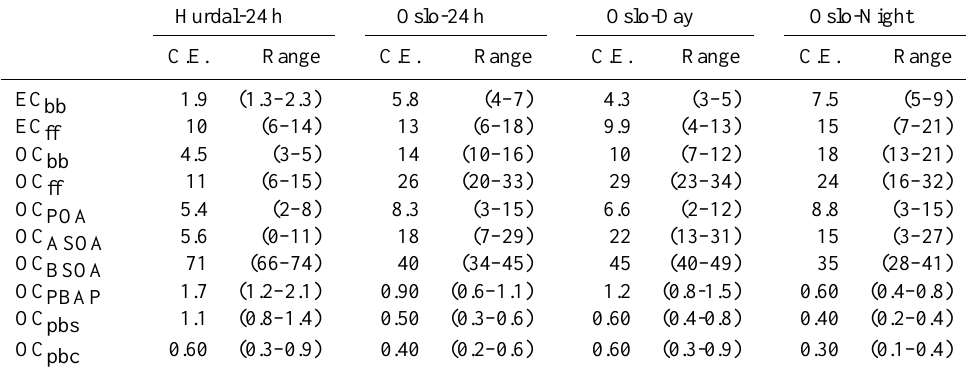
Table 8. Calculated percentage contributions to total carbon from LHS analysis, PM 1 , summer sampling (19 June–15 July 2006). C.E. is central estimate (50th percentile), range is 10th–90th percentiles of LHS results.